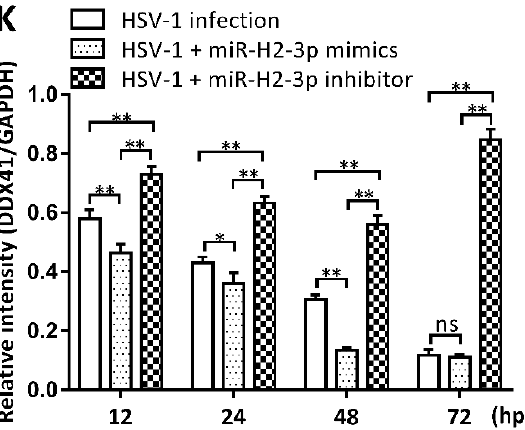
Figure 3. miR-H2-3p contributed to the downregulation of DDX41 during HSV-1 infection in THP-1 cells. ( A – C ) THP-1 cells were infected with HSV-1 at an MOI of 1 for indicated time point ( A ) or at an MOI of 0.01, 0.1, and 1 for 24 h ( B ), or transfected with miR-H2-3p inhibitor or negative control inhibitor at the indicated final concentration, and then infected with HSV-1 at an MOI of 1 for 24 h ( C ). The cells were harvested, and total RNA was extracted for determining the miR-H2-3p expression using qRT-PCR. The values were normalized to U6 sno RNA and standardized to 1 in 6 hpi ( A ) or an MOI of 0.01 ( B ) or NC treatment ( C ). ( D ) Analysis of correlation between miR-H2-3p expression ( A ) and DDX41 expression ( E ) during HSV-1 infection with an MOI of 1. R, Reliability; p, Pearson correlation coe ffi cient. ( E , F ) THP-1 cells were infected with HSV-1 at an MOI of 1 or mock (Mock) for indicated time periods. The level of DDX41 protein was determined by immunoblotting ( E ) and the relative density of DDX41 protein using ImageJ software ( F ). The values were normalized to GAPDH, using GAPDH as a loading control. ( G – J ) THP-1 cells were transfected with miR-H2-3p mimics or negative control mimics at the final concentration of 100 nM or miR-H2-3p inhibitor or negative control inhibitor at the final concentration of 100 nM, and then infected with HSV-1 at an MOI of 1 for 24 h. The level of DDX41 protein was determined by immunoblotting ( G , I ) and relative density of DDX41 protein using ImageJ software ( H , J ). The values were normalized to GAPDH, using GAPDH as a loading control. ( K ) Summary for panel of F, H, and J. Data are the means ± SD ( n = 3) from one representative experiment. Similar results were obtained from three independent experiments. * P < 0.05; ** P < 0.01.